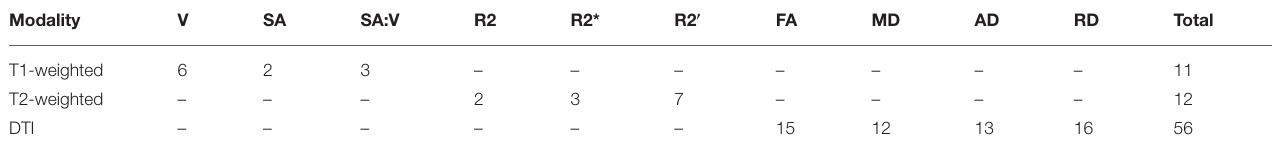
TABLE 7 | Feature composition of the SVM based feature selection + MLP classification combination using features from multiple MRI modalities.